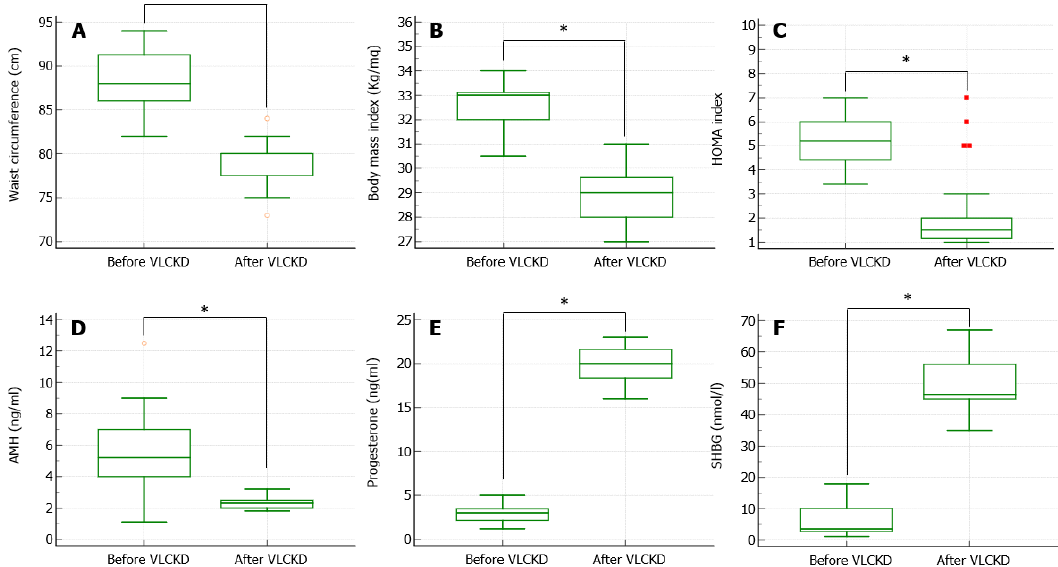
Figure 1. Anthropometric, metabolic, and hormonal parameters measured before and after a 3-month-long period of very low calorie ketogenic diet (VLCKD). ( A ) shows a significant reduction in the waist circumference. ( B ) shows a significant reduction in body mass index. ( C ) shows a significant reduction in insulin resistance, measured using the Homeostatic Model Assessment (HOMA) for Insulin Resistance index. ( D ) shows a significant reduction in the anti-Müllerian hormone (AMH) serum levels. ( E ) shows a significant increase in the progesterone serum levels, measured at the 21st day of the menstrual cycle. ( F ) shows a significant increase in the sex-hormone binding globulin (SHBG) serum levels. * p < 0.05.